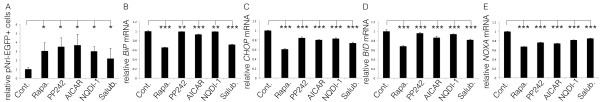
Drug screening in the RP #5 iPSC-derived rod photoreceptor cells. (A) Relative number of pNrl-EGFP-positive rod photoreceptor cells derived from #5 iPSCs after treatment with each therapeutic reagent. N = 9. (B-E) Relative mRNA levels of BiP (B), CHOP (C), BID (D), and NOXA (E) in the pNrl-EGFP-positive cells cultured with rapamycin, PP242, AICAR, NQDI-1, and salubrinal at 5 weeks after differentiation. Each reagent increased the rod photoreceptor cell survival at 5 weeks, whereas ER stress and apoptotic markers were suppressed. N = 3 for B-E. Rapa., rapamycin; Salub., salubrinal. *p < 0.05, **p < 0.01, ***p < 0.001. Mean ± SD relative to cont. (with each p-values of marked by *) for Cont., Rapa., PP242, AICAR, NQDI-1, Salbr. in (A) 1 ± 0.182, 3.02 ± 0.920, 3.49 ± 0.976, 3.67 ± 1.22, 2.99 ± 0.513, 2.19 ± 1.12 (all, p < 0.0001); (B) 1 ± 0.005, 0.654 ± 0.001, 0.990 ± 0.001, 0.932 ± 0.001, 0.989 ± 0.001, 0.714 ± 0.004 (all, p < 0.0001); (C) 1 ± 0.002, 0.608 ± 0.003, 0.842 ± 0.009, 0.802 ± 0.003, 0.830 ± 0.003, 0.733 ± 0.008 (all, p < 0.0001); (D) 1 ± 0.016, 0.681 ± 0.006, 0.954 ± 0.007, 0.864 ± 0.002, 0.934 ± 0.004, 0.816 ± 0.008 (all, p < 0.0001); (E) 1 ± 0.005, 0.671 ± 0.001, 0.760 ± 0.004, 0.743 ± 0.003, 0.816 ± 0.001, 0.849 ± 0.006 (all, p < 0.0001). These data were obtained by technical triplicate and not by biological triplicate. All statistical analyses in this figure were carried out by One-way ANOVA Dunnett’s test.